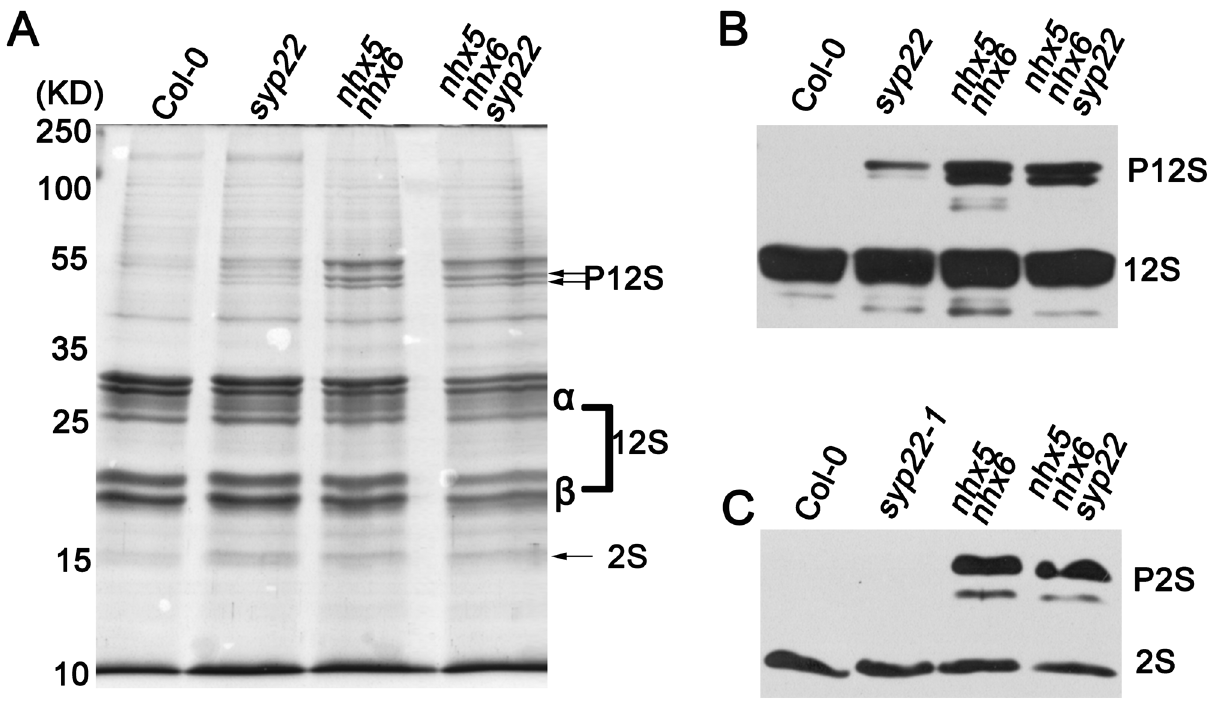
Fig 6. Precursors of the storage proteins are accumulated in the seeds of nhx5 nhx6 syp22 . (A) SDS-PAGE stained with the Coomassie blue. Total proteins were extracted from the mature seeds. 10 μ g proteins were loaded in each lane. (B) and (C) Immunoblot analysis of 12S globulin (B) and 2S albumin